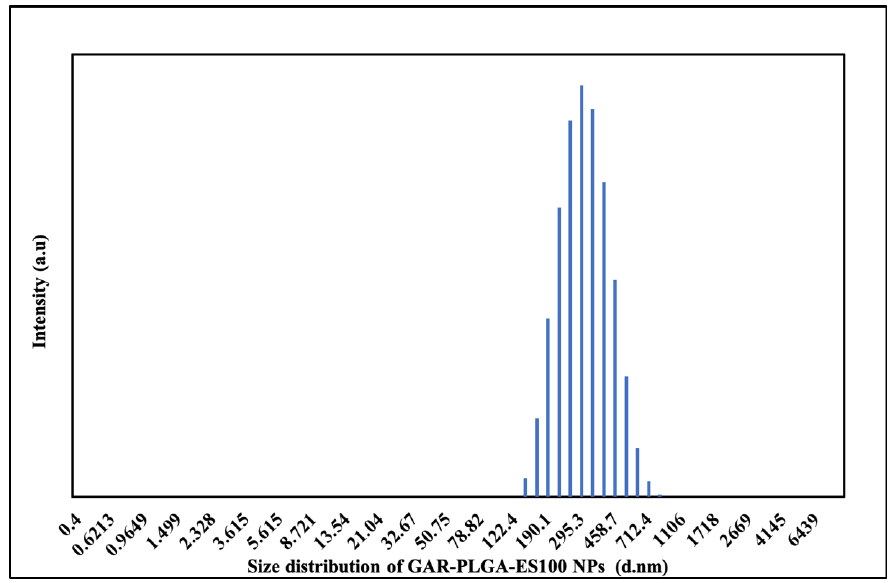
Figure 1. Size distribution of GAR-PLGA-ES100 NPs by DLS measurement.